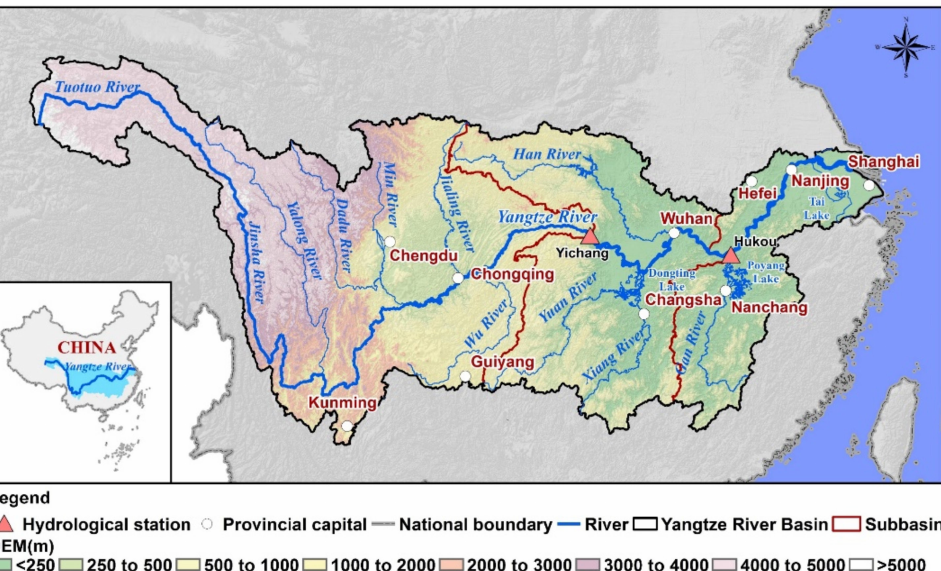
Figure 1. Geographical location of the study